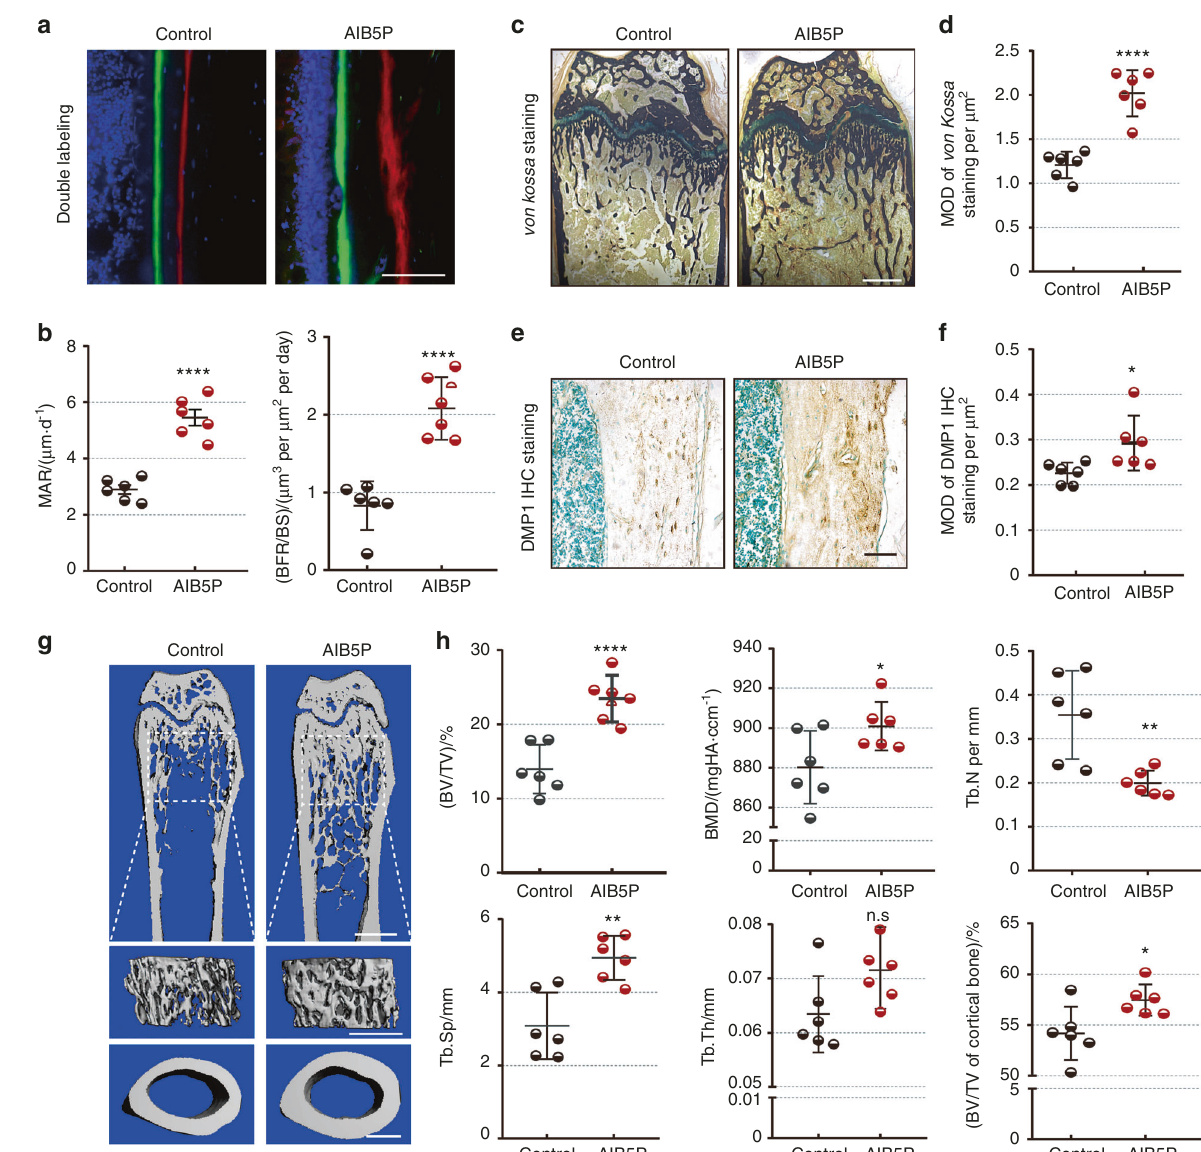
Fig. 4 AIB5P enhances bone formation in vivo. Six mice in each group were administered AIB5P or vehicle (100 μ g·kg − 1 , every 3 days, intravenous, total 1.5 months). Femurs were collected for further experiments. a High-magni fi cation calcein and xylenol orange double labeling in femurs. Bar = 100 μ m. The distance between the two fl uorescent lines shows the amount of new bone deposition. b Quanti fi cation of the mineral apposition rate (MAR) and the bone formation rate per bone surface (BFR/BS) value. n = 6. c, d von Kossa staining and relative quanti fi cation of femur sections. Bar, 200 μ m. Samples from six mice were used for statistics. e, f Representative anti-DMP1 IHC staining images and semiquanti fi cation. Samples from six mice were used for statistics. g Representative micro-CT of mouse femurs. Upper, longitudinal transverse sections at midshaft scans. Bar, 1 mm. Middle, trabecular bone underneath the growth plate. Bar, 500 μ m. Lower, cortical bone. Bar, 500 μ m. h Quanti fi cation analysis of micro-CT. Bone material density (BMD), bone volume per tissue volume (BV/TV), trabecular bone numbers (Tb.N), trabecular bone space (Tb.Sp) and trabecular bone thickness (Tb.Th) of trabecular bone compared between the vehicle control and AIB5P groups. BV/TV of the cortical bone was also compared. n =